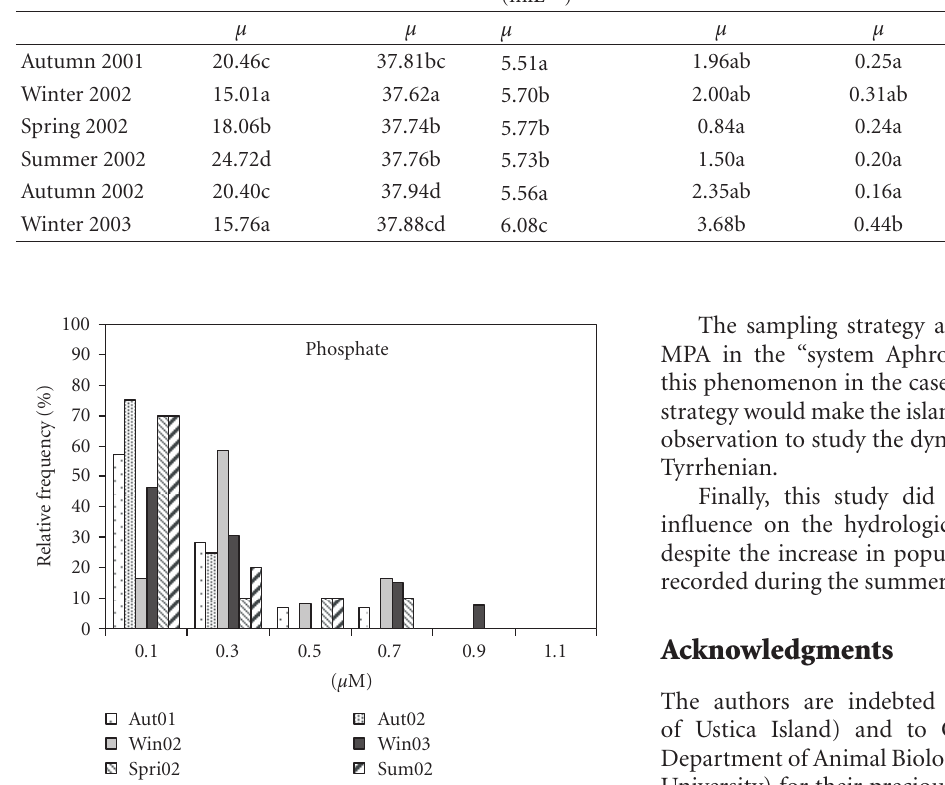
Figure 8: Phosphate seasonal distributions in frequency classes (autumn 2001–winter 2003). Labels report the class lower value.